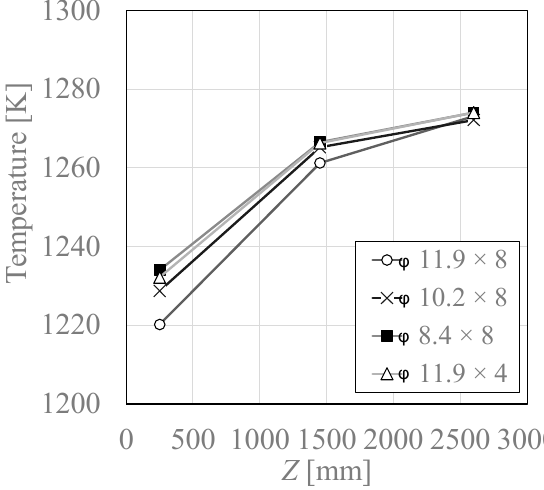
Figure 8. Temperature distribution when the temperature at the point Z = 2600 mm is 1273 K at E H2 = 0%. Input = 174 kW, λ = 1.2, P = +15 Pa.